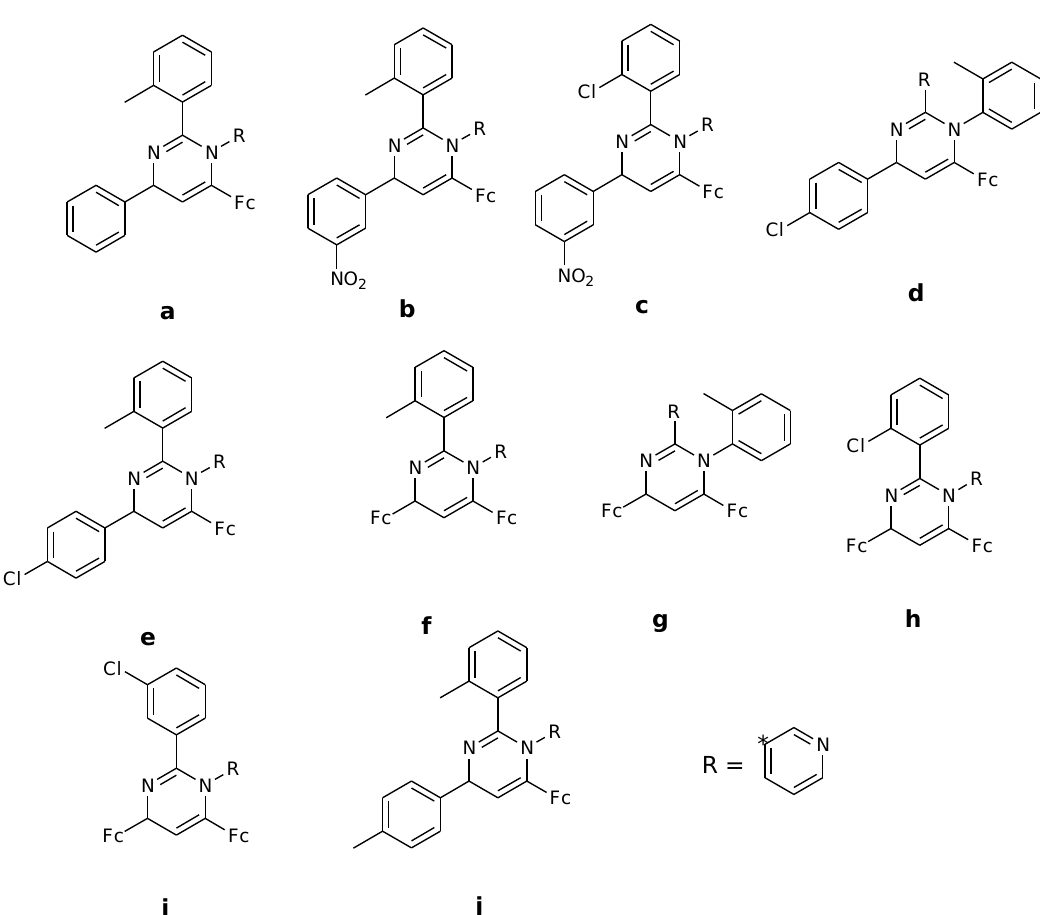
Figure 26. Chemical structures of ferrocene with 1,4-dihydropyrimidine derivatives ( 75a – j ).